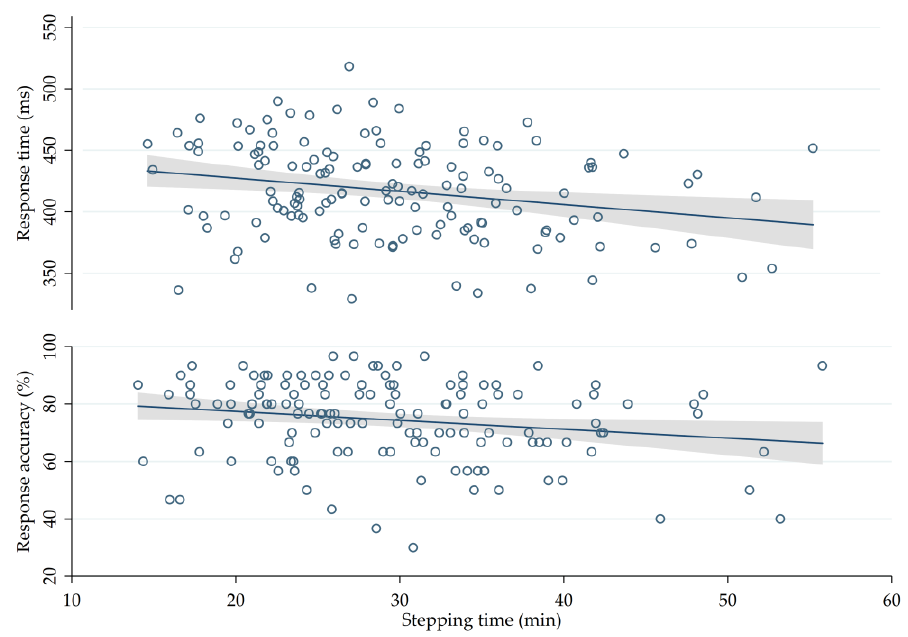
Figure A2. Scatterplot showing the significant correlations between class time stepping and response inhibition reaction time ( r = − 0.24, p < 0.005) and accuracy ( r = − 0.19, p < 0.05).